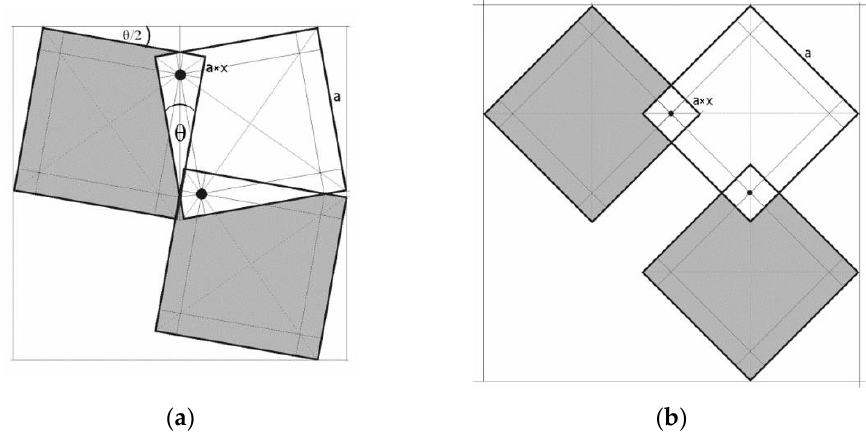
Figure 3. Connection of the rotating squares with the axes on their surface for the closed position ( a ) and for the open position ( b ).